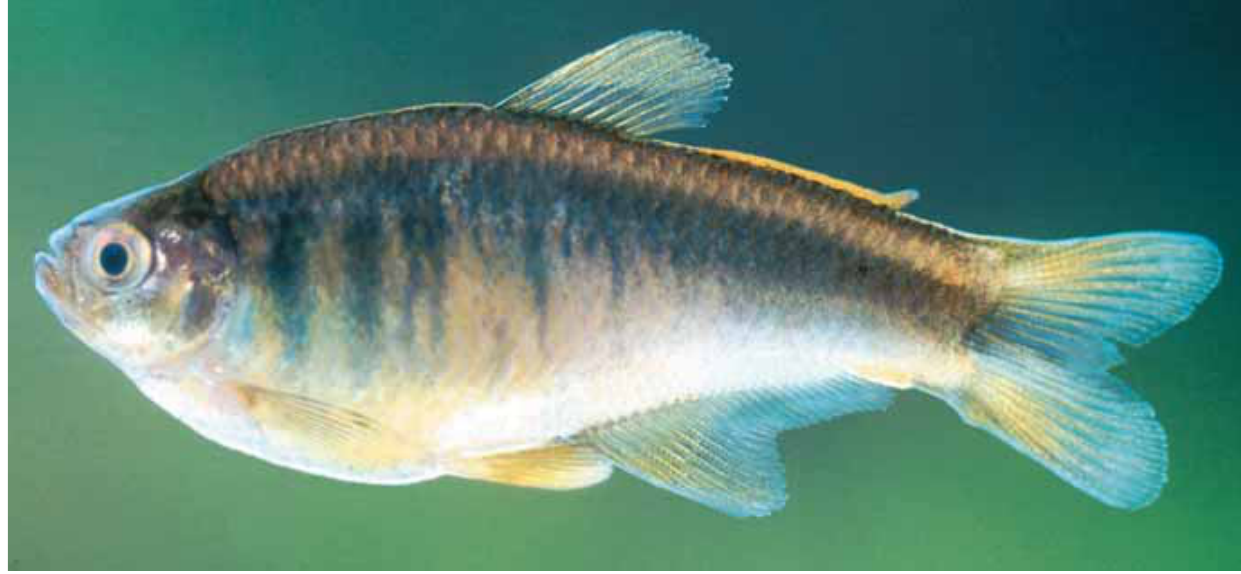
Fig. 2 . Lophiobrycon weitzmani , paratype , LIRP 4338, male, SL 31.1 mm; Brazil, Minas Gerais, rio Grande basin, Município de Delfinópolis, Estância Carmem Sílvia, córrego Bom Jesus, (20º12’10’’S 46º55’22”W), aquarium field photograph.